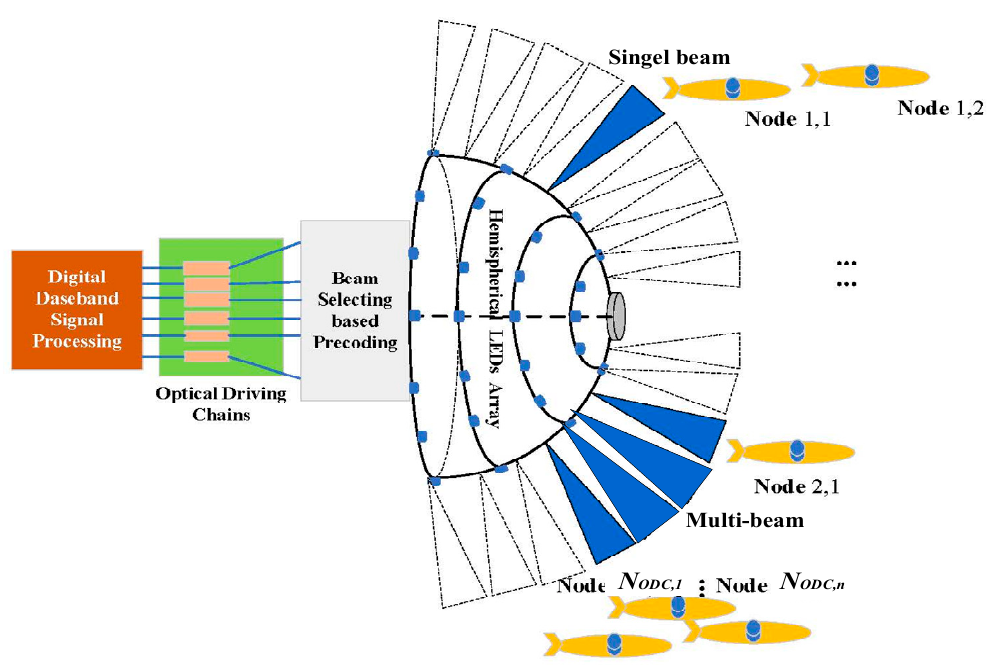
Figure 2. Schematic diagram of the hemispherical multiple-beam space division multiple access transmission.